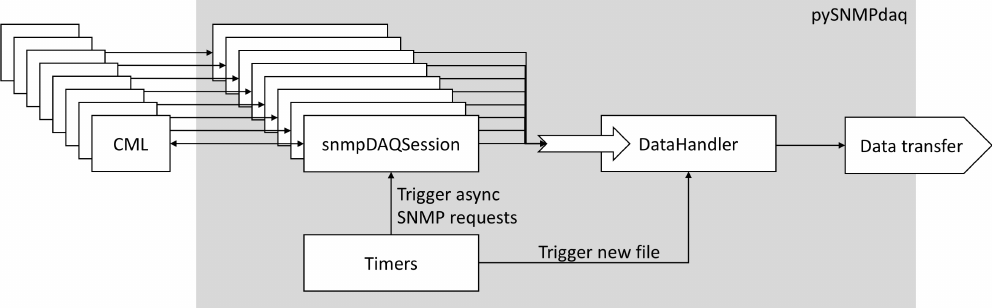
Figure 2. Schematic of the structure of our real-time data acquisition software pySNMPdaq with its three different kind of processes. The inter-process communication is established via Queues and Events . With the SNMP requests the data flows from the CMLs to the snmpDAQSessions and from there to the DataHandler , which writes data to files in regular intervals and can transfer the data to a further